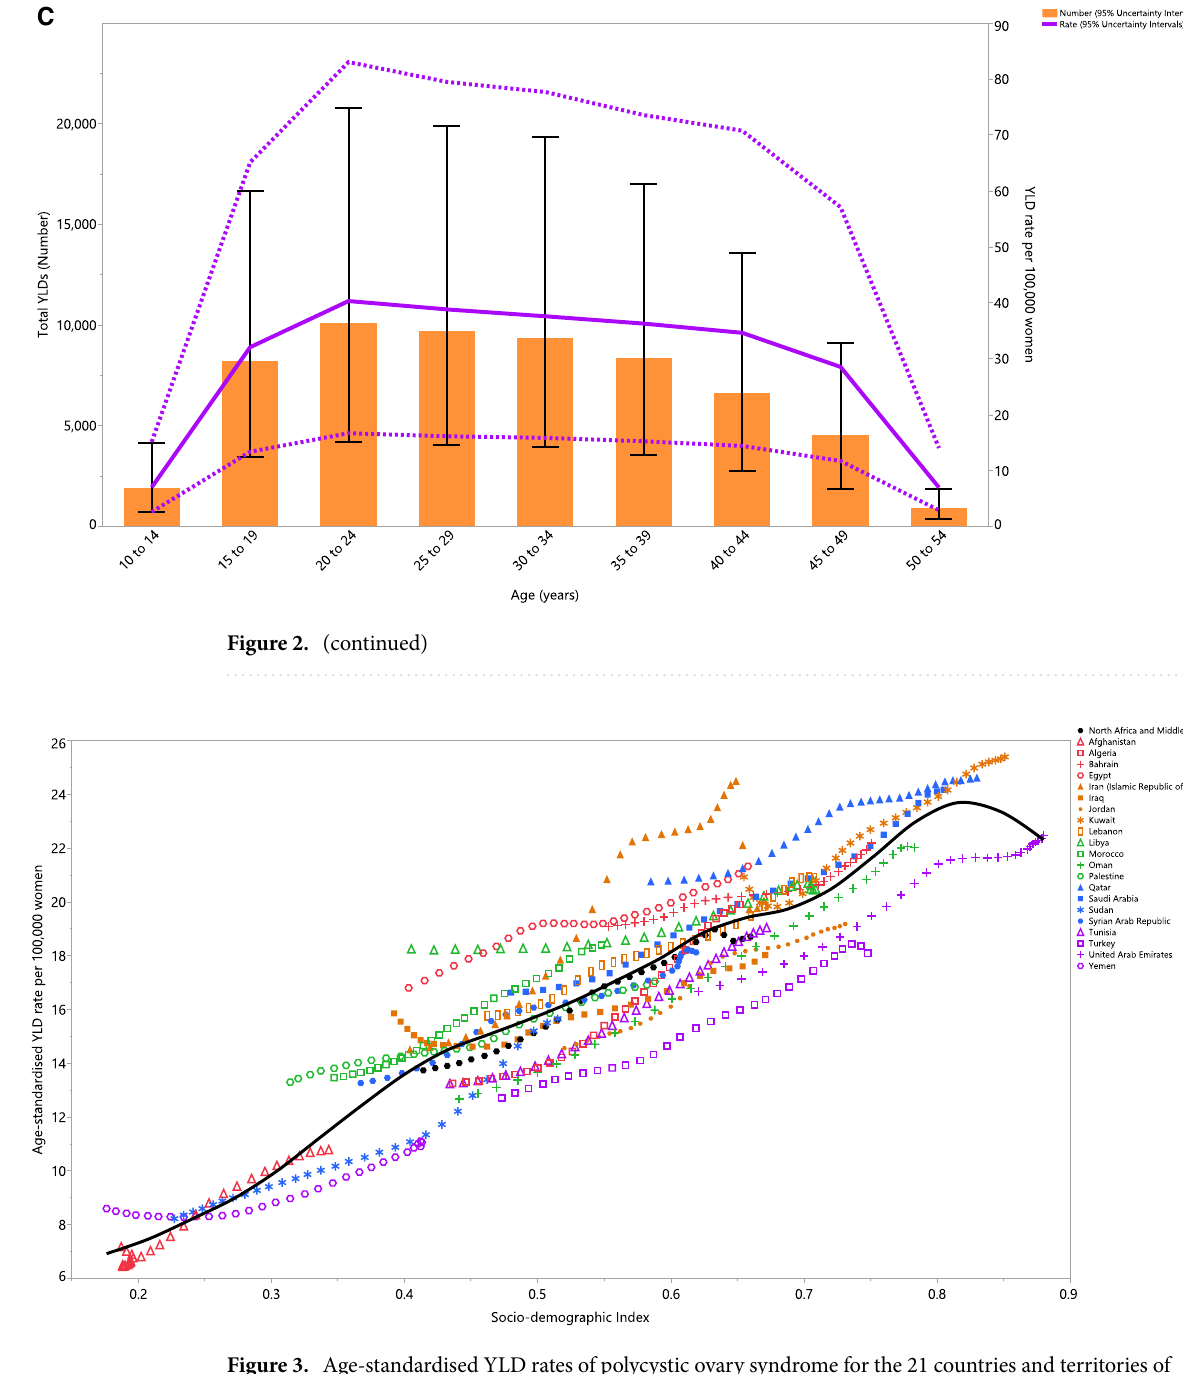
Figure 3. Age-standardised YLD rates of polycystic ovary syndrome for the 21 countries and territories of the Middle East and North African region by Socio-demographic Index, 1990–2019; Expected values based on the Socio-demographic Index and the disease rates in all locations are shown as the black line. Countries above the solid line (e.g. Qatar and Morocco) had higher than expected burdens, while those below the line (e.g. Turkey and Jordan) had lower than expected burdens. Thirty points are plotted for each GBD region and show the observed age-standardised YLD rates from 1990 to 2019 for that region. YLD = years lived with disability. (Generated from data available from http:// ghdx. healt hdata. org/ gbd- resul ts-